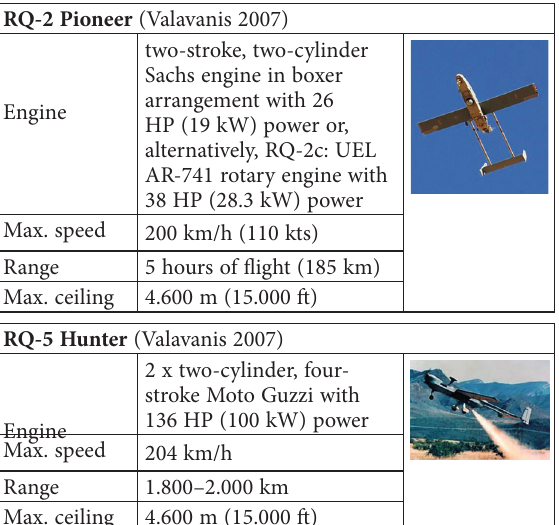
Fig. 9. Schematic representation of an electric